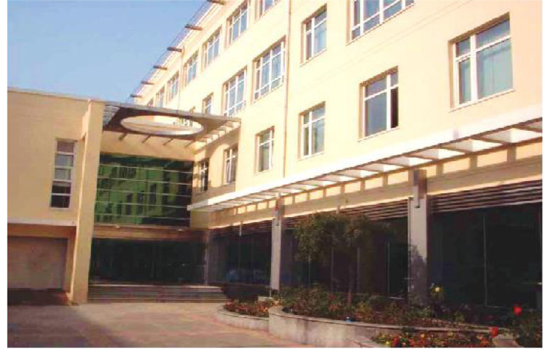
Fig. 8 Office building of the Tianjin Meijiang ecological